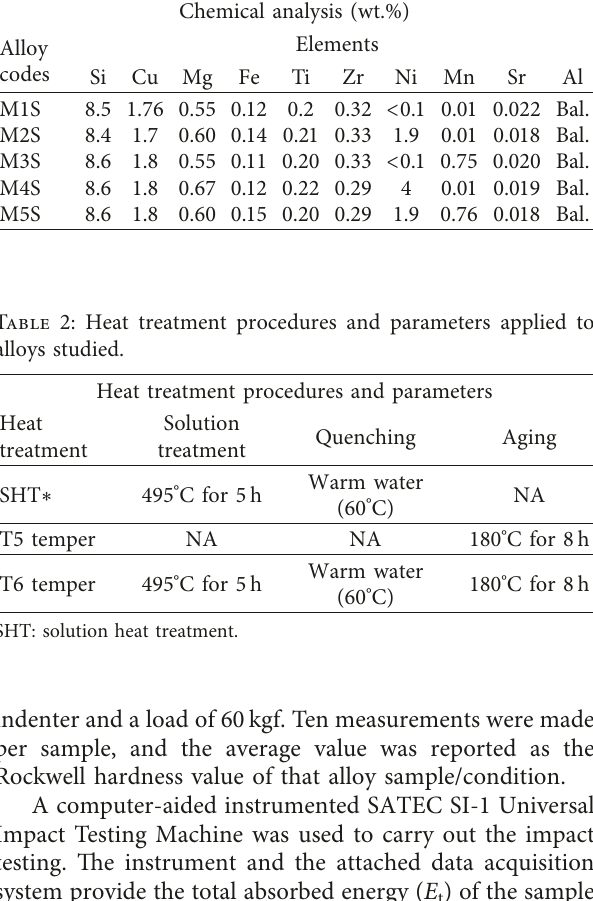
Table 1: Chemical composition of the alloys investigated in this study. Chemical analysis (wt.%) Alloy codes